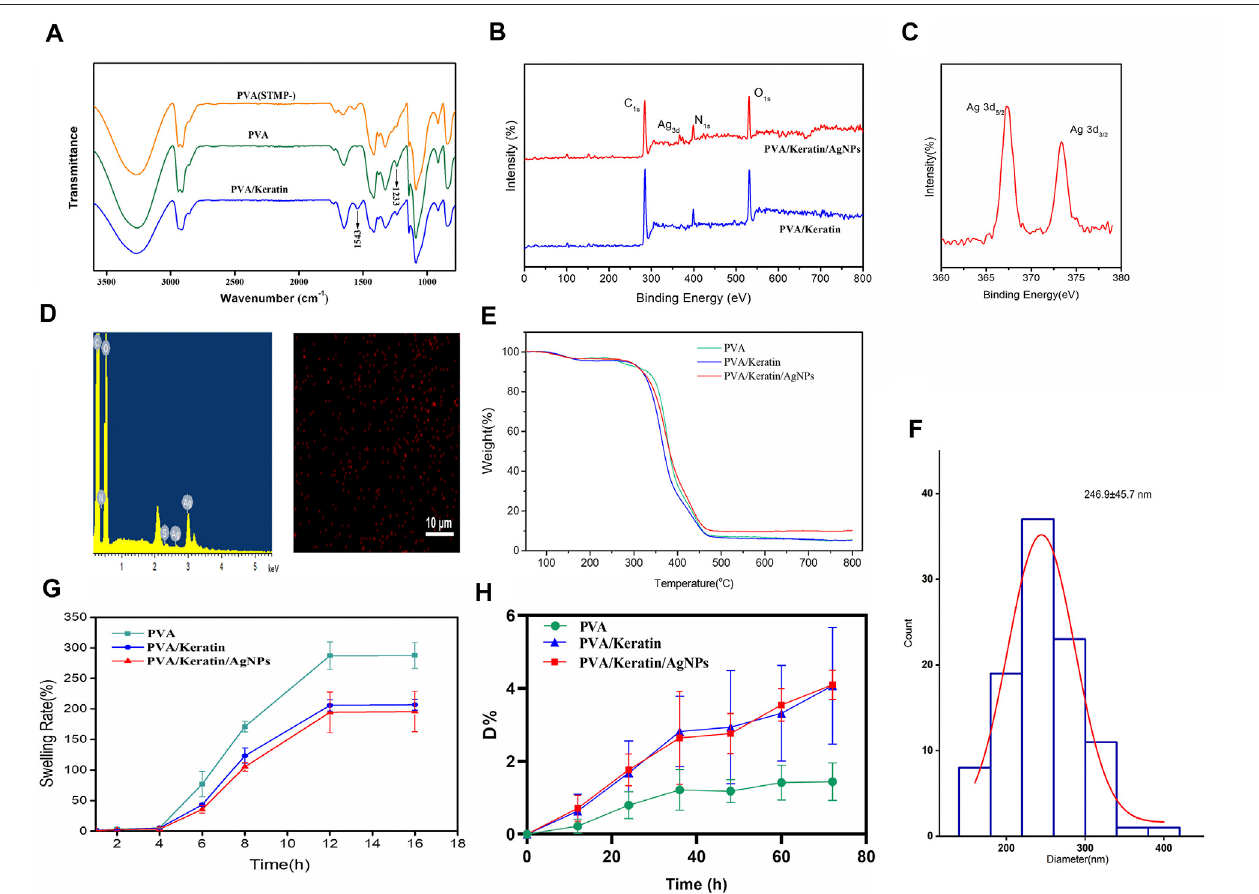
FIGURE2| Characterizationsofhydrogels. (A) ATR-FTIRdiagramofPVA,PVAtreatedwithSTMPandPVA/Keratin. (B) ThewidescanXPSspectraofPVA/Keratin and PVA/Keratin/AgNPs. (C) Ag3d high-resolution spectra of PVA/Keratin/AgNPs. (D) EDS spectrum of PVA/Keratin/AgNPs and SEM-EDX elemental mapping image of Ag. (E) Thermogravimetric curves of PVA, PVA/Keratin, and PVA/Keratin/AgNPs. (F) Diameter distribution of silver nanoparticles. (G) Swelling rate of PVA, PVA/ Keratin, and PVA/Keratin/AgNPs. (H) Enzymatic degradation of PVA, PVA/Keratin, and PVA/Keratin/AgNPs.